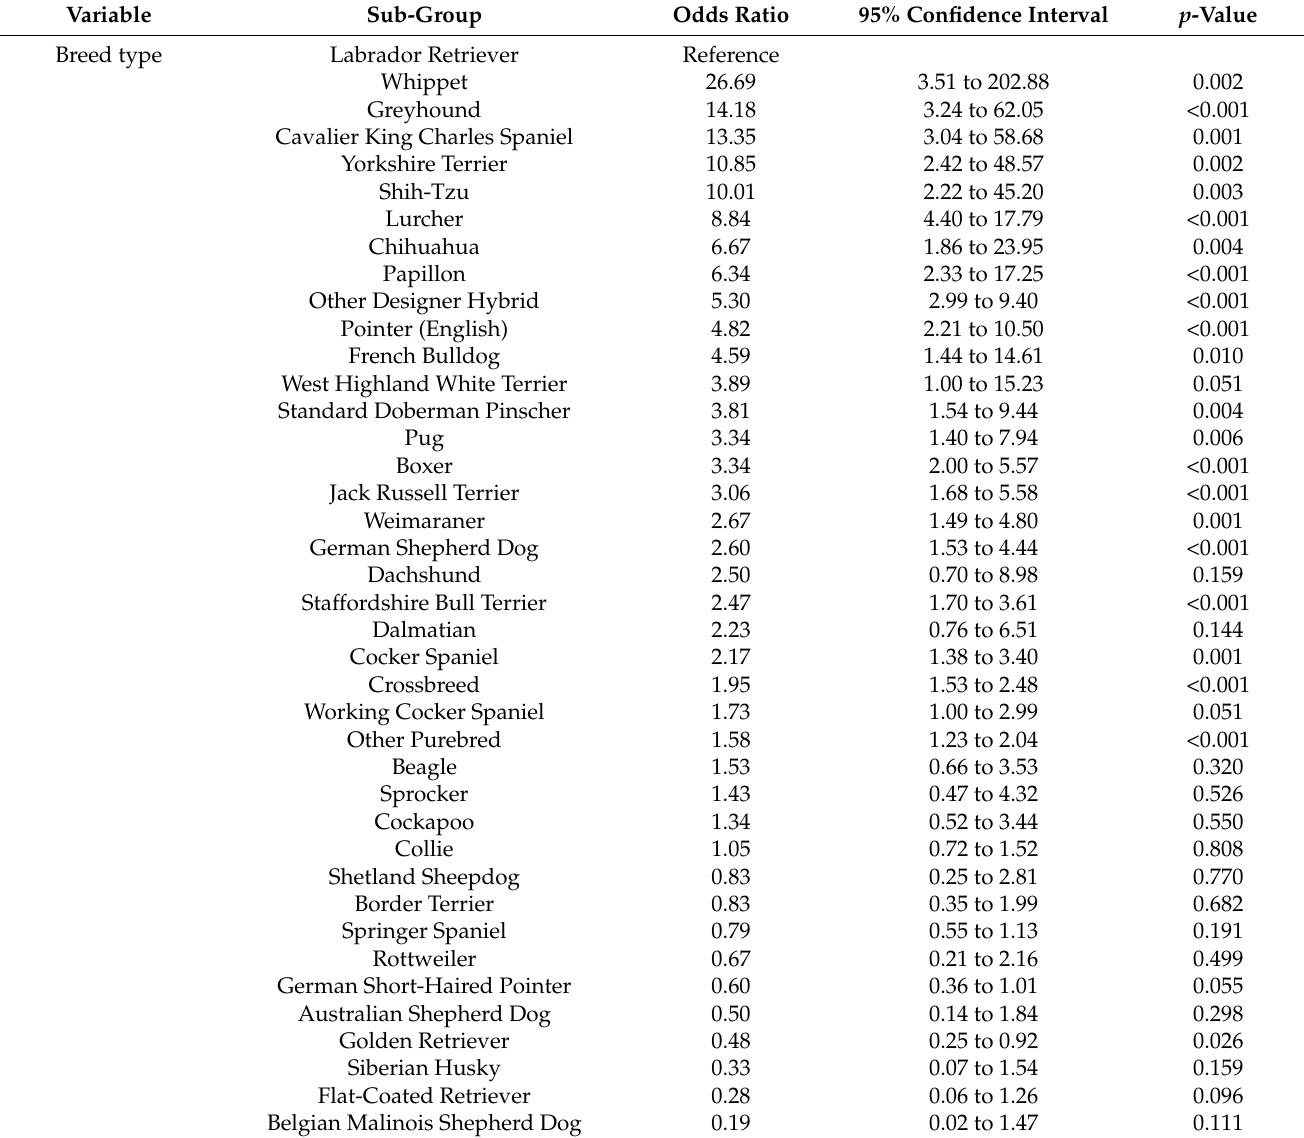
Table A3. Univariable logistic regression results for breed type associated with coat use in winter. Increased odds of coat use are indicated by an odds ratio greater than one, an odds ratio lower than one indicates reduced odds of coat